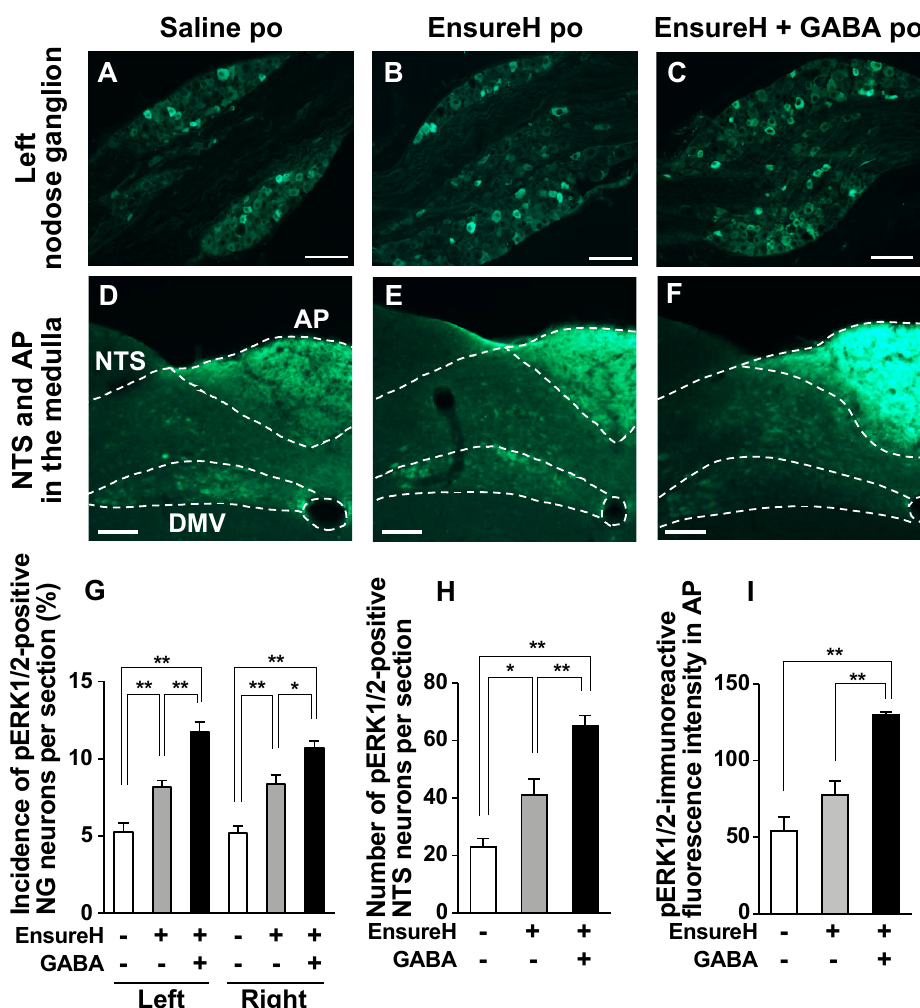
Figure 6. The coadministration of liquid diet EnsureH and GABA potentiates the postprandial activation of neurons in nodose ganglia (NGs), nucleus tractus solitarius (NTS), and area postrema (AP). ( A – F ): Left NG ( A – C ) and medial NTS and AP in the medulla ( D – F ) sections immunostained for ERK1/2 phosphorylation 30 min after po administration of EnsureH (40 mL/kg), EnsureH + GABA (40 mL/kg and 200 mg/kg), or saline (40 mL/kg) in overnight-fasted mice. Scale bar, 100 µm. ( G – I ): The incidence of pERK1/2-positive neurons in the left and right NG neurons ( G ) and the number of them in the bilateral NTS neurons ( H ). The fluorescence intensity of pERK1/2-immunoreactivity per unit area in AP is indicated in I. * p < 0.05, ** p < 0.01 by one-way ANOVA followed by Tukey’s test. n = 4. DMV, dorsal motor nucleus of vagus nerves. po, peroral. GABA: Gamma-aminobutyric acid. Dotted line: borderline indicating brain region. EnsureH+, po administration of EnsureH (gray columns). GABA+, po administration of EnsureH containing GABA (black columns). EnsureH– and GABA–, po administration of saline (white columns).